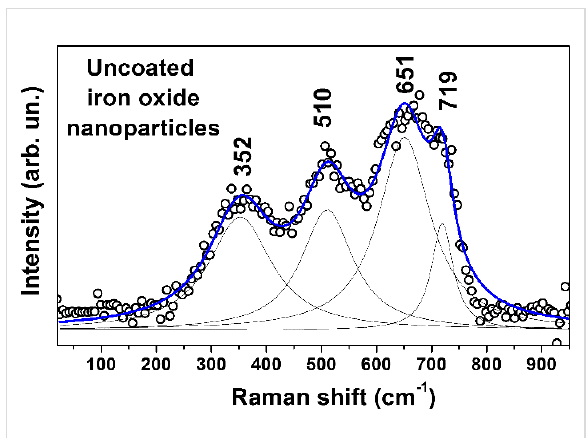
Figure 4: Raman spectrum of uncoated nanoparticles. Fitting of the peaks in the region up to 950 cm − 1 is shown. The peaks at 352, 510, 651, and 719 cm − 1 correspond to the oxygen vibrations in maghemite γ -Fe 2 O 3 . The solid lines are the approximation of the experimental spectrum by Gaussian distribution.